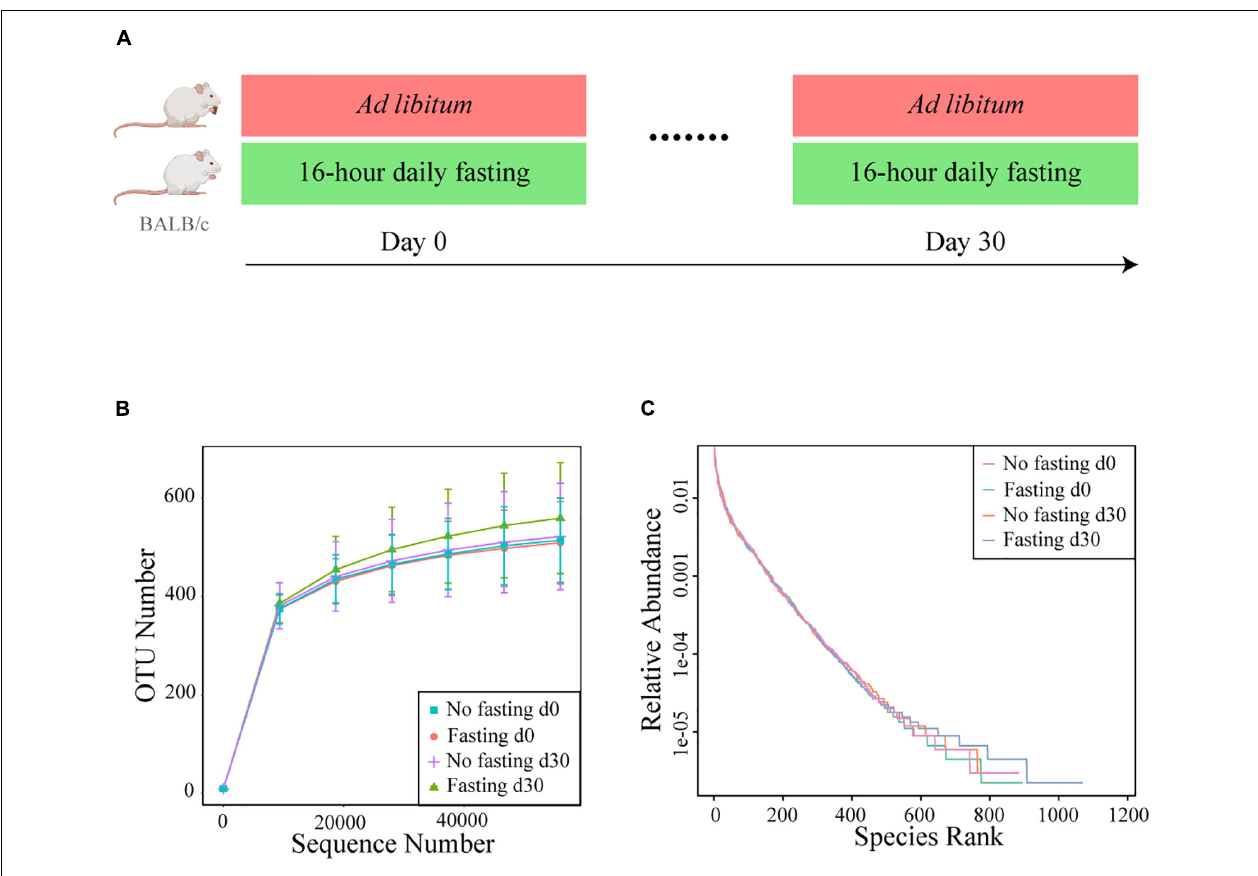
FIGURE 1 | Study design and bacterial 16S rRNA sequencing. (A) Experimental design for the 16-h daily fasting group ( n = 8) and the no fasting group fed Ad libitum ( n = 6). Food and water are only freely available during the other 8 h. The fecal samples were collected at the beginning (Day 0) and end (Day 30) the fasting. After fecal DNA isolation, the bacterial V3-V4 region of 16S rRNA gene was sequenced to map the gut microbiota. The images of mouse model were generated with assistance of Biorender.com. (B) Rarefaction curves of detected bacterial OTUs of the gut microbiome from no fasting and fasting groups each reach saturation stage with increasing sequencing depth. Each vertical bar represents standard error. (C) The rank abundance curve depicting the bacterial species richness and evenness in the gut microbiome of fasting vs. no fasting mice before or after